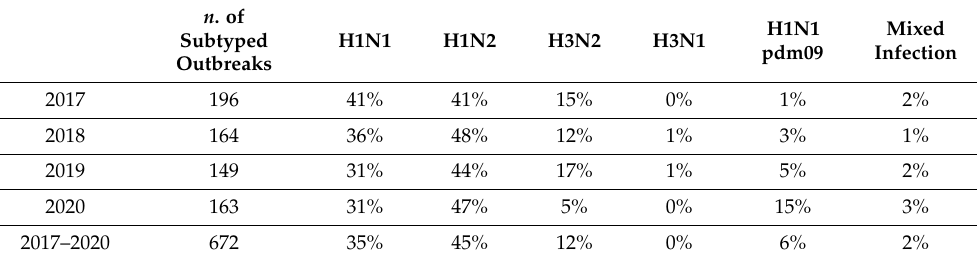
Table 2. swIAV subtype positivity per year considered. Strains were classified in subtypes: